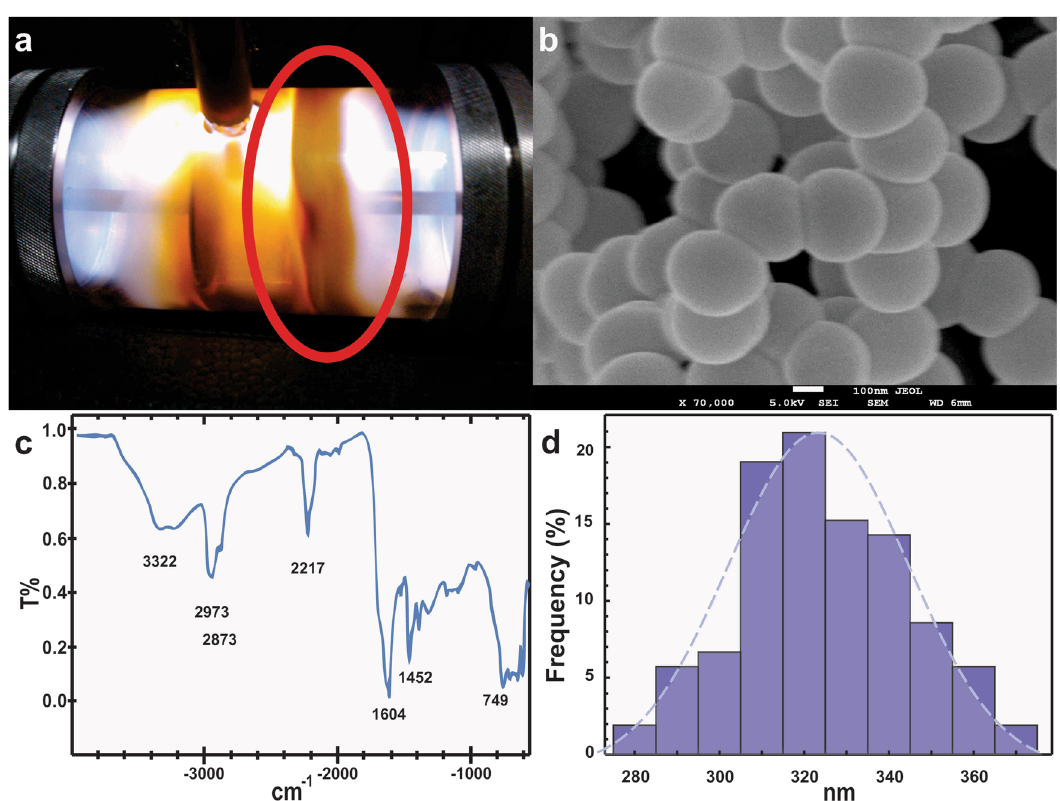
Fig. 1 a PPPyN (red circle) synthesis in the plasma reactor, b SEM image of PPPyN, c infrared spectrum of PPPyN, and d PPPyN size